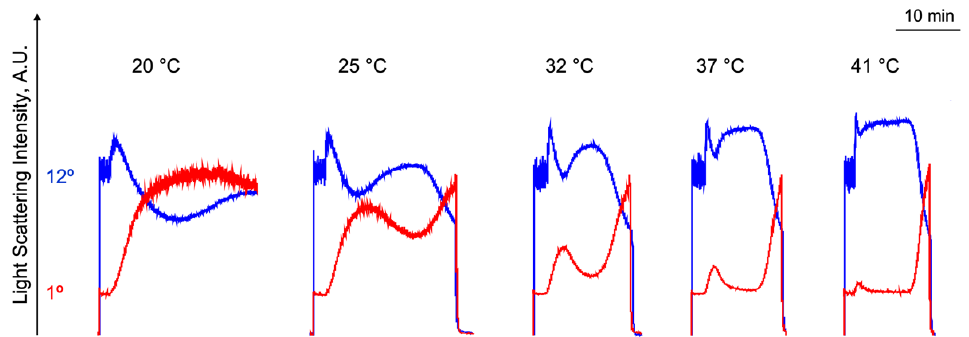
Figure 4. ADP-induced platelet transformation at different temperatures. PRP diluted in HEPES buffer (1 × 10 7 platelets/mL) was added to the cuvette with a continuous stirring (1200 rpm) at 25 °C. After 2 min of incubation, ADP (300 nM) was added and dynamical changes in light scattering intensity were registered for the scattering angles of 1° and 12° at 20 ° С , 25 ° С , 32 ° С , 37 ° С , and 41 ° С . For better visualization, the data of LSI at 12° were multiplied by 50. Shown are the original representative traces from four independent experiments.